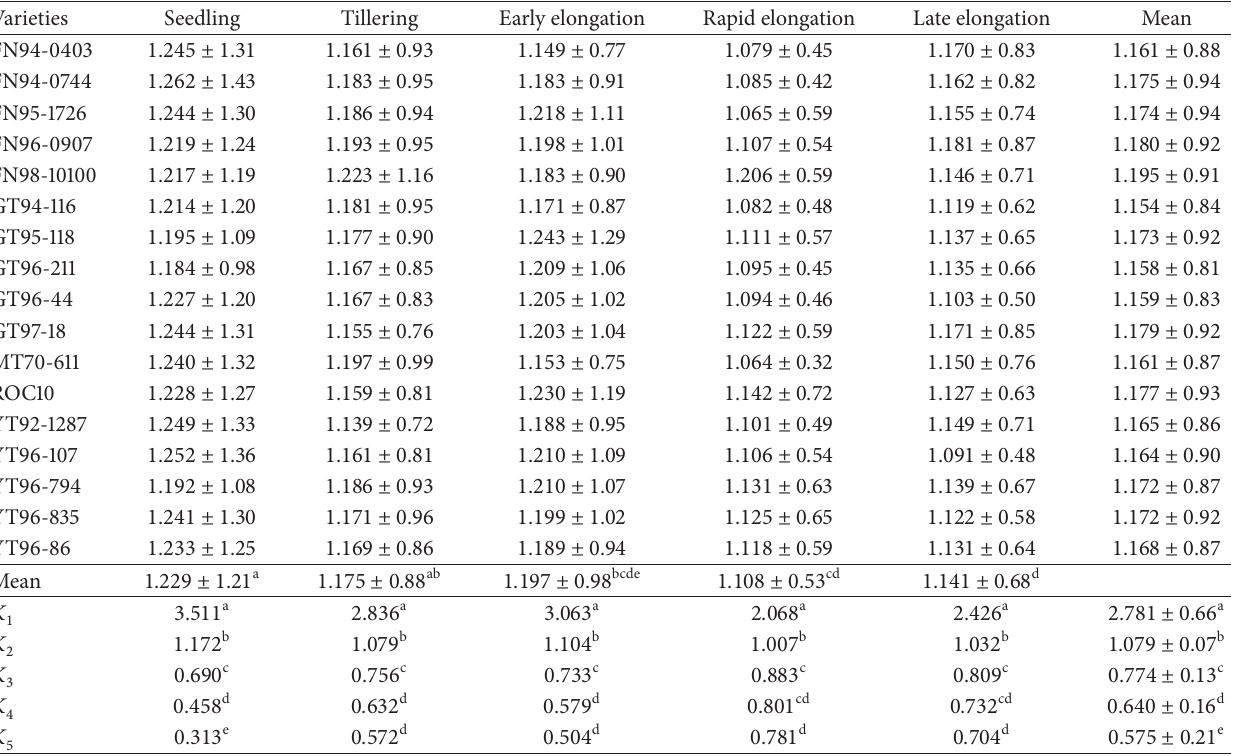
Table 5: Seasonal changes of extinction coefficient in sugarcane